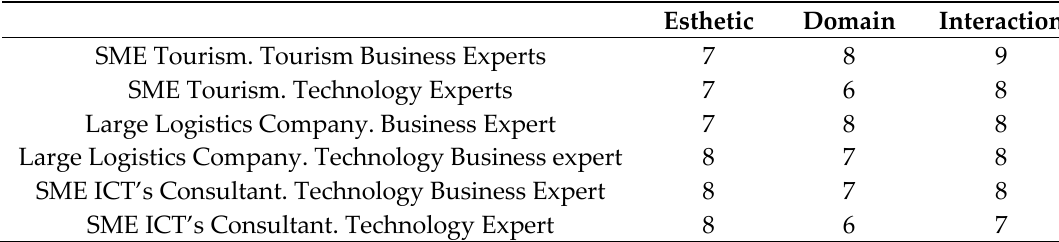
Table 1. Valuation of the